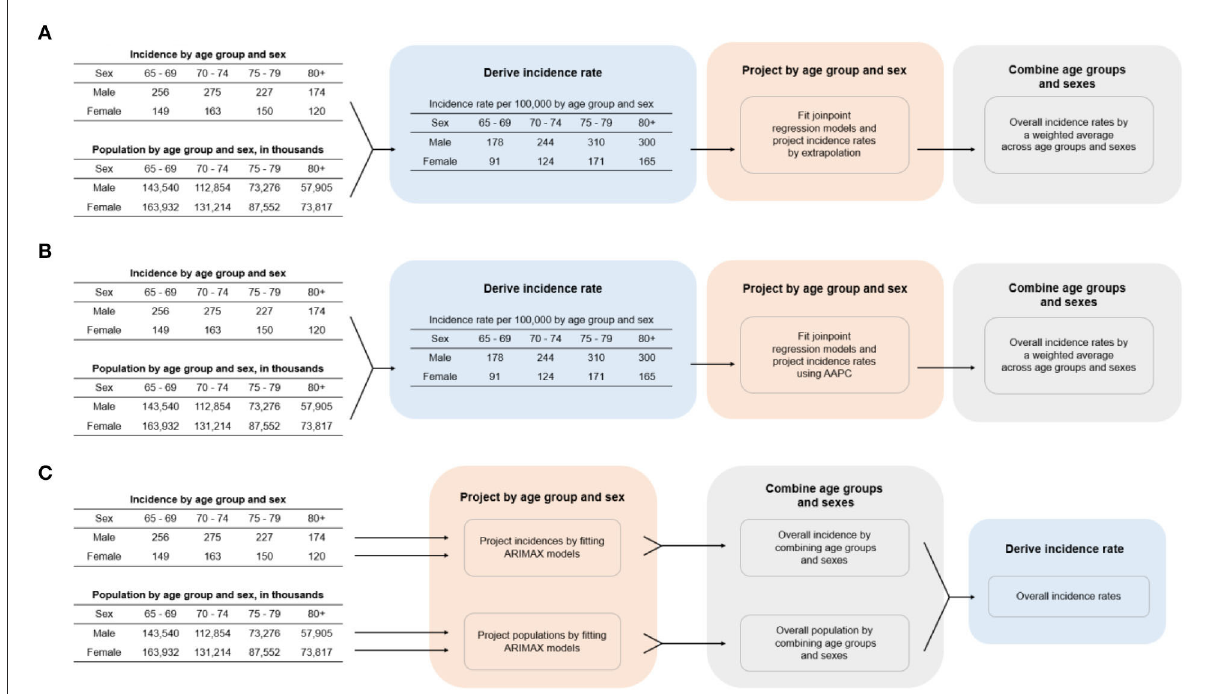
FIGURE1 Procedures for calculating cancer incidence rate for the three projection methods. (A) Joinpoint regression, (B) AAPC, (C) ARIMAX. AAPC, average annual percentage change; ARIMAX, autoregressive integrated moving average with exogenous